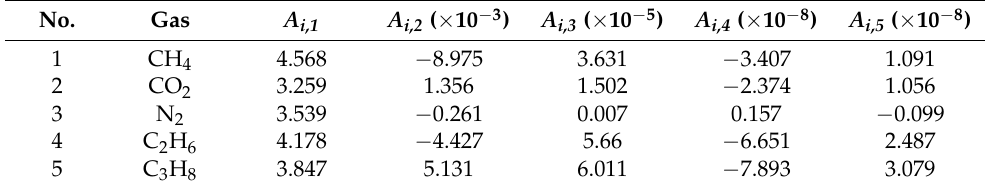
Table 1. Regressed constants of Equation